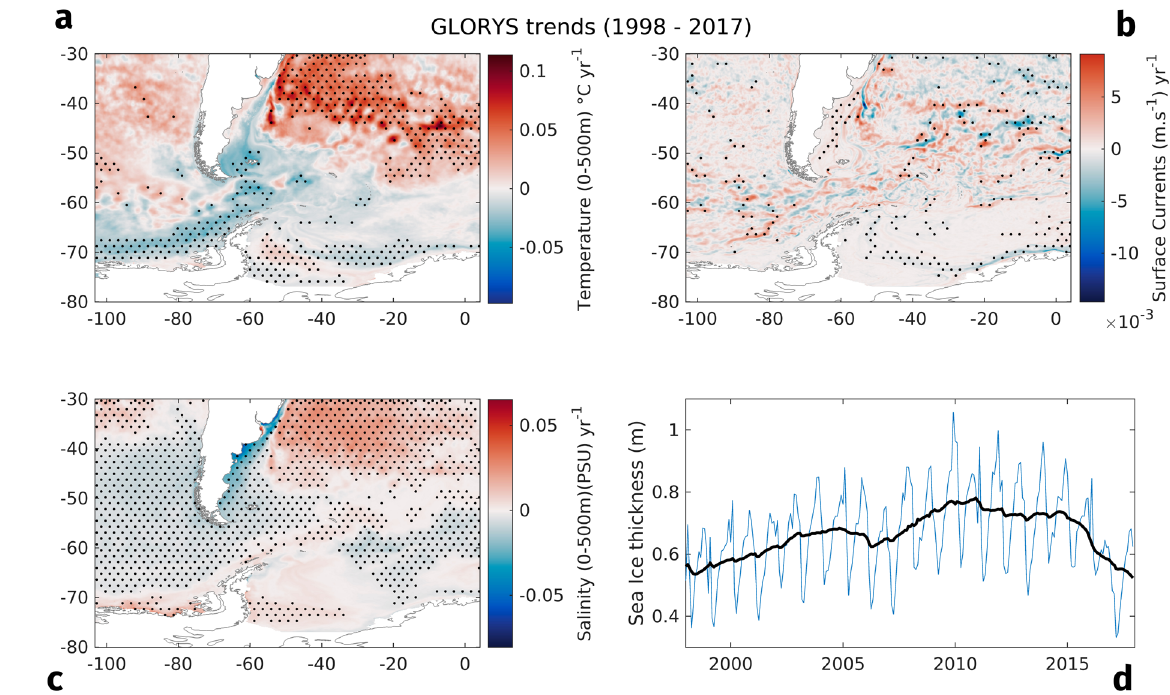
Figure 4. Yearly trends over Antarctic Peninsula through results of GLORYS Reanalysis data between 1998 and 2017, variables: (a) mean water temperature in °C for the first 500 meters; (b) Currents magnitude at the surface (m s -1 ); (c) mean water salinity for the first 500 meters; (d) Mean sea-ice thickness (m), blue line is monthly mean, and dark line represents the yearly mean. Black dots represent the areas with significance of 0.05. Created with Climate Data Toolbox for Matlab (Greene et al.